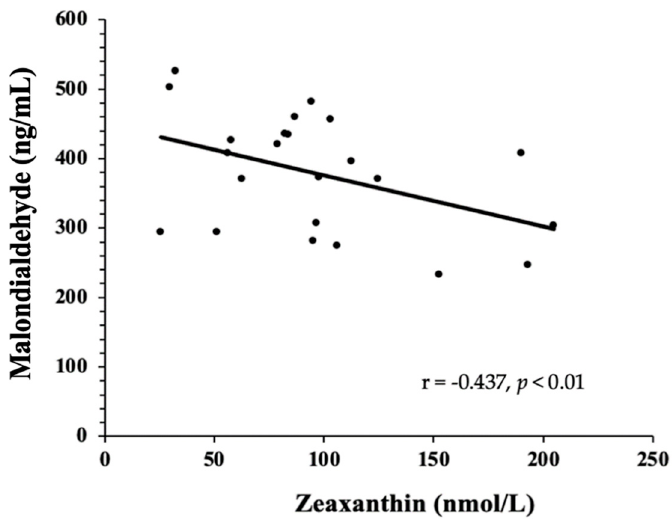
Figure 3. The concentratio of lipid peroxidation product, MDA negatively correlated with the concentration of plasma zeaxanthin after EGG intervention for n = 24 subjects.